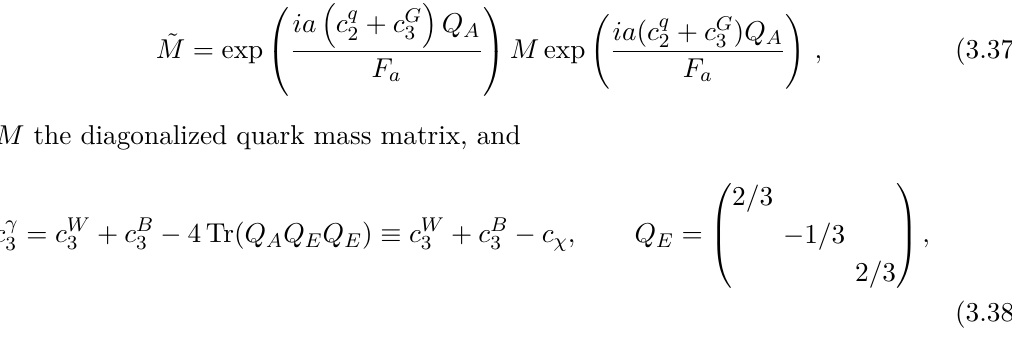
Figure 2 . Crosscheck of the typical QCD axion band [5, 45] (blue) and our instanton-flower diagram results (orange) in the ( m a , G aγγ ) plane. We relate our ˜ E/c G parameter from the canonical DFSZ and KSVZ models via ˜ E/c G explicit choices of ˜ E/c G = 0 , 1 , and 4 / 3 3